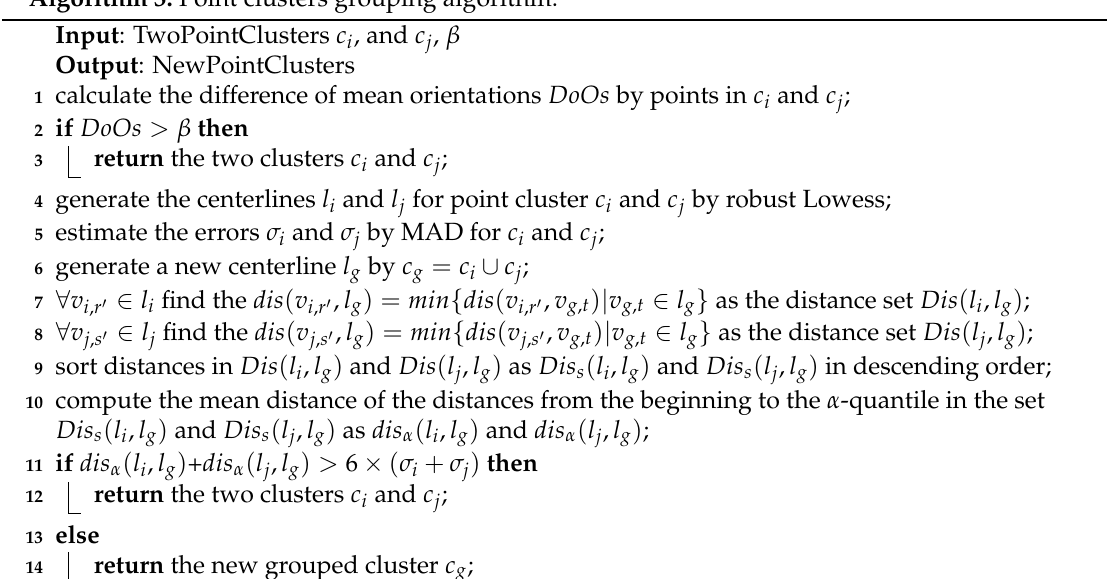
Algorithm 3: Point clusters grouping